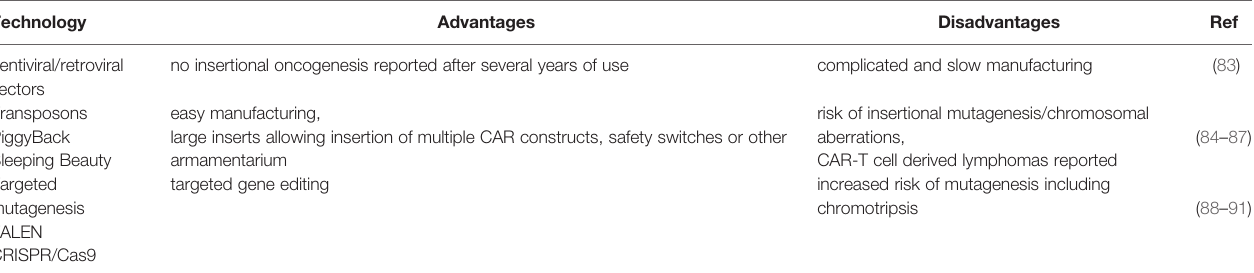
TABLE 3 | Summary of different gene editing techniques with the main dis/advantages of their use. Technology